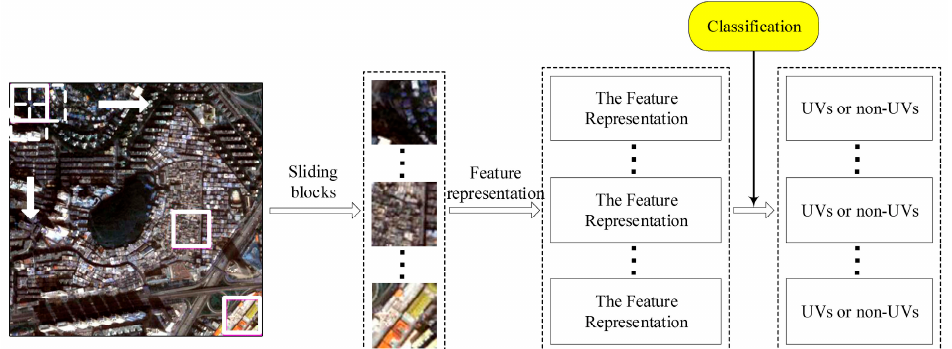
Figure 6. Flowchart of scene-driven object detection: take urban village (UV) detection as an example. The scene trained for deep networks is gained through sliding scenes. By comparing the scene and scenes which have been labeled “UVs”, the training scenes can be labeled UVs or non-UVs, and the object detection result can be achieved.